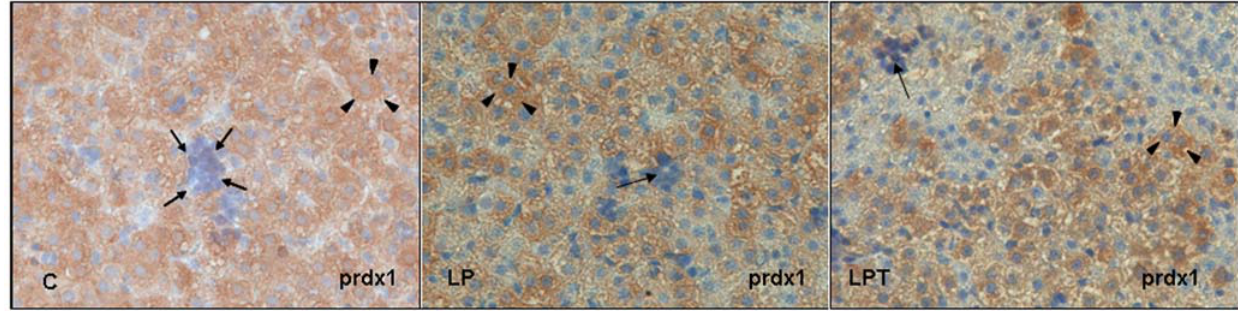
Figure 8. Immunostaining of PRDX1 in liver from 5 day-old newborn control, LP and LPT rats. Hepatocytes (arrows head) appear in brown staining while hematopoietic cells (black arrows) are unstained for PRDX1 for both